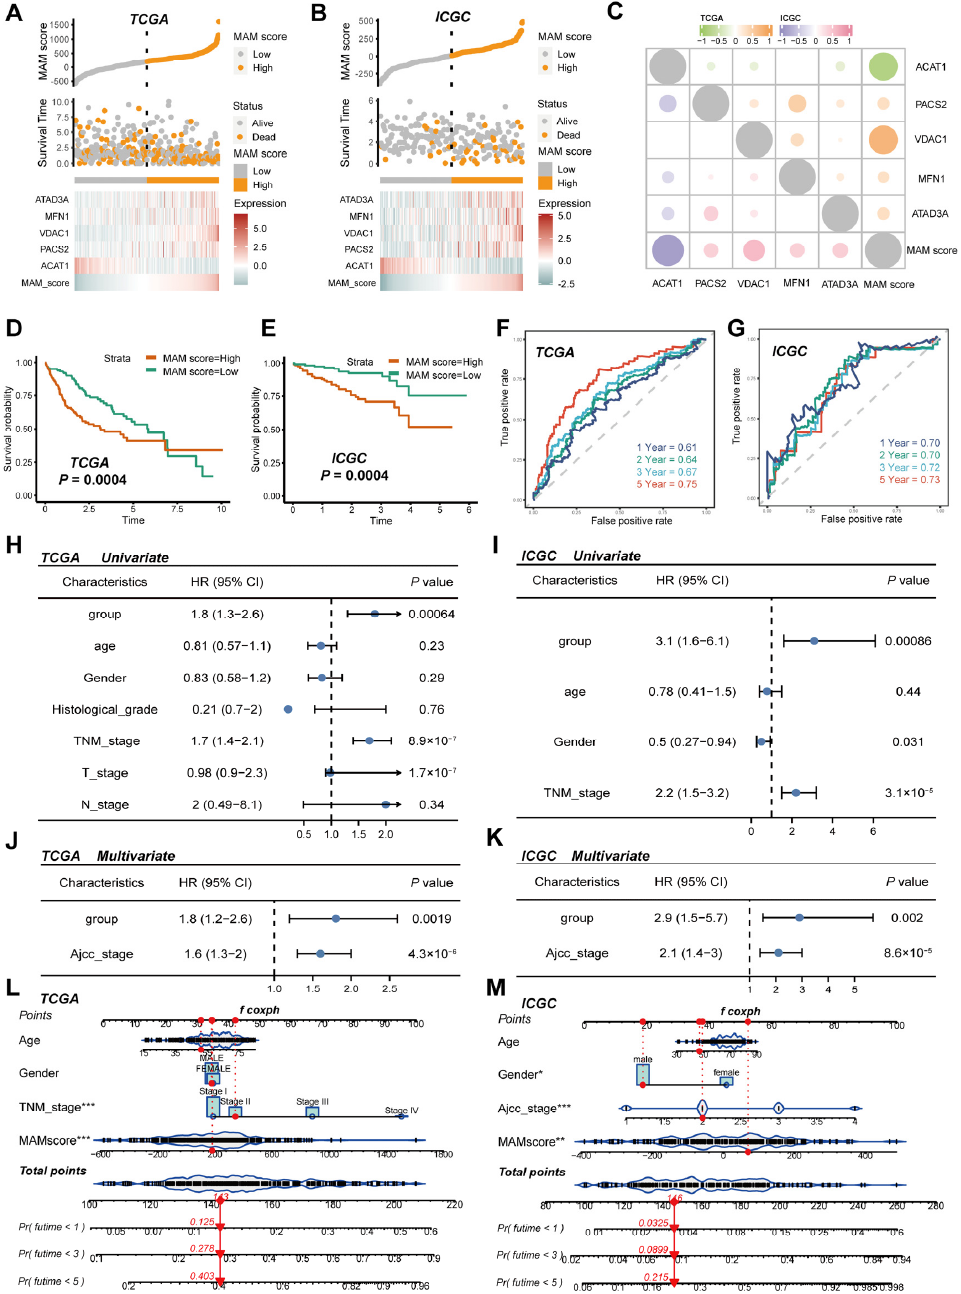
Figure 3. Construction and verification of the MAM scores in HCC. ( A , B ): Distribution of the MAM scores and survival status of HCC patients in the TCGA and ICGC datasets. ( C ): Expression correlation between the MAM score and its constitutive genes. ( D , E ): KM curves of the low- and high-MAM − score groups in the TCGA and ICGC datasets. ( F , G ): Time-dependent ROC analysis of the TCGA and ICGC datasets for MAM scores at 1, 3, 4, and 5 years. ( H – K ): Univariate Cox regression and multivariate Cox regression analyses for MAM scores and other clinical characteristics in the TCGA and ICGC datasets. ( L , M ) Nomogram predicts 1-, 3-, and 5-year OS of HCC samples based on the TCGA and ICGC datasets. * p < 0.05; ** p ≤ 0.01; *** p ≤ 0.001.